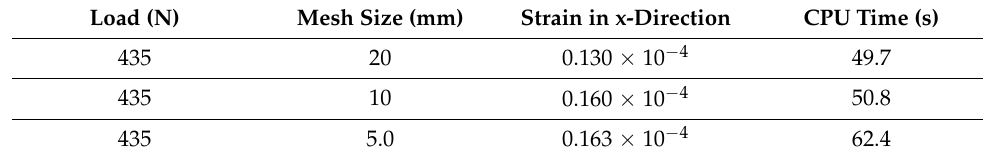
Table A9. Mesh convergence study related to Section 3.